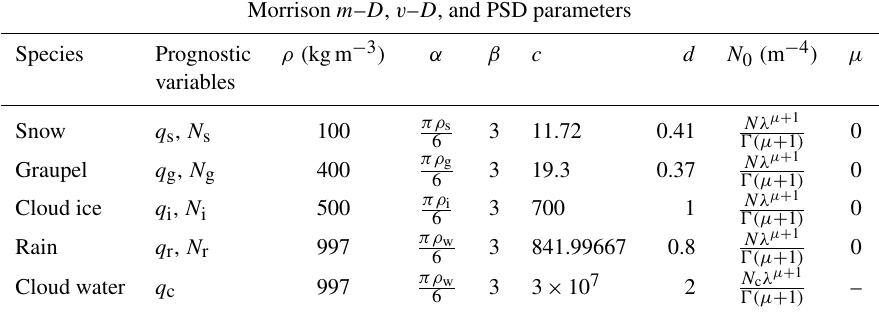
Table 2. Morrison mass–size relationship ( m = αD β ), terminal-velocity–size relationship ( v =[ ρ 0 /ρ ] 0 . 54 cD d ), and gamma PSD parameter values used for each species. N c used for cloud water µ and N 0 calculations is a constant 100cm − 3 . Cloud water µ is calculated as a function of N c using an empirical relationship described in Martin et al. (1994).